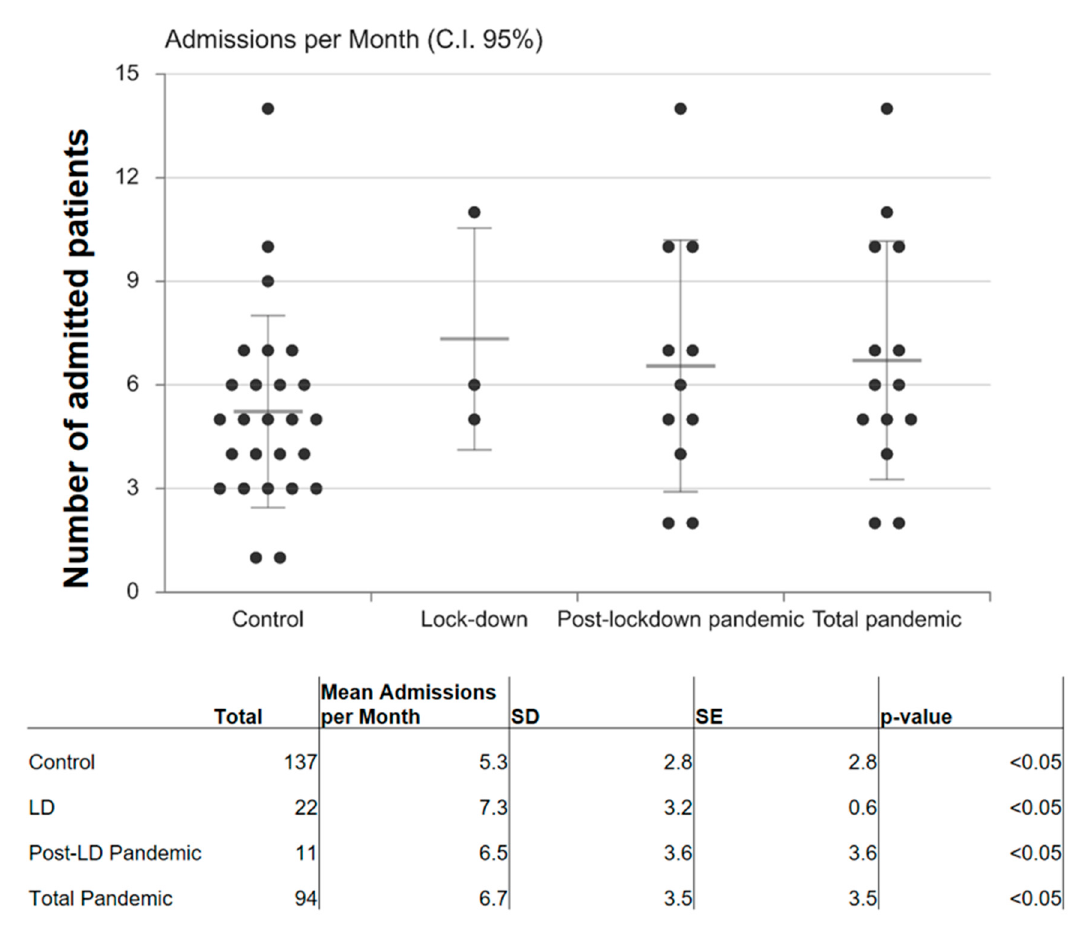
Statistical analysis revealed a mean of 13.5 admissions/month (Figure 2).